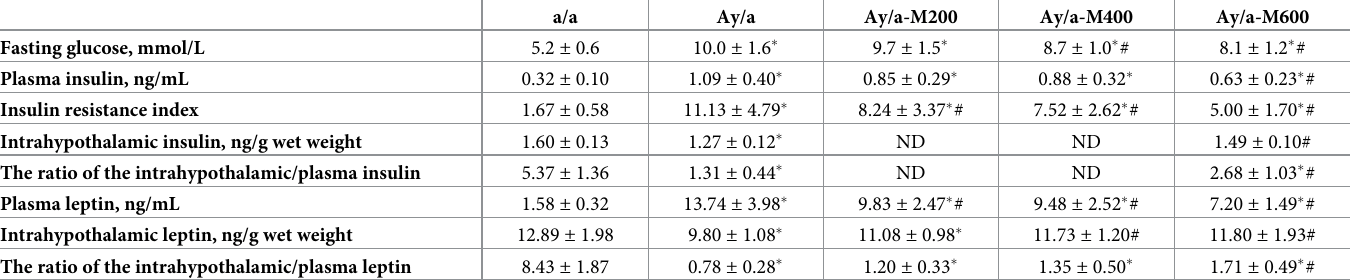
Table 2. The plasma levels of glucose, insulin and leptin and the intrahypothalamic leptin and insulin content in obese agouti-mice and the effect of metformin